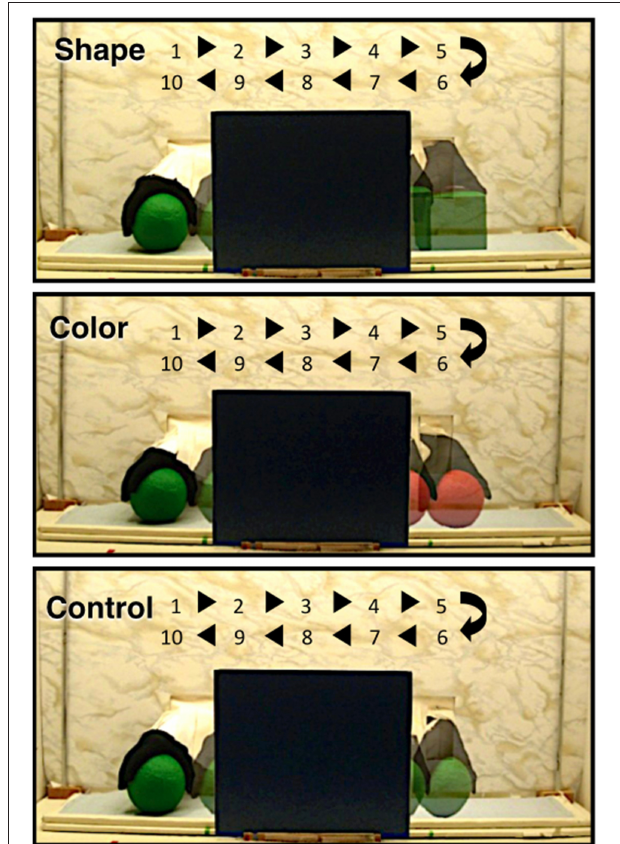
FIGURE 1 | The shape difference, color difference, and control test events used by Wilcox and her colleagues in previous studies ( Wilcox et al., 2010, 2012, 2014a) and used in the present experiments. The figure shows one event cycle. The numbers and arrows indicate the time (in s) and the space over which the objects moved during the event cycle. Infants saw 2 complete event cycles during each test